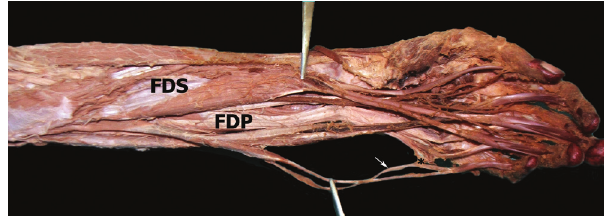
Figure 1 - Anterior aspect of the left forearm. FDS: fl exor digitorum super-FDS: flexor digitorum super- ficialis, FDP: flexor digitorum profundus. White arrow indicates the FDP tendon originating from the FDS muscle, and the black asterix indicates the intertendinous